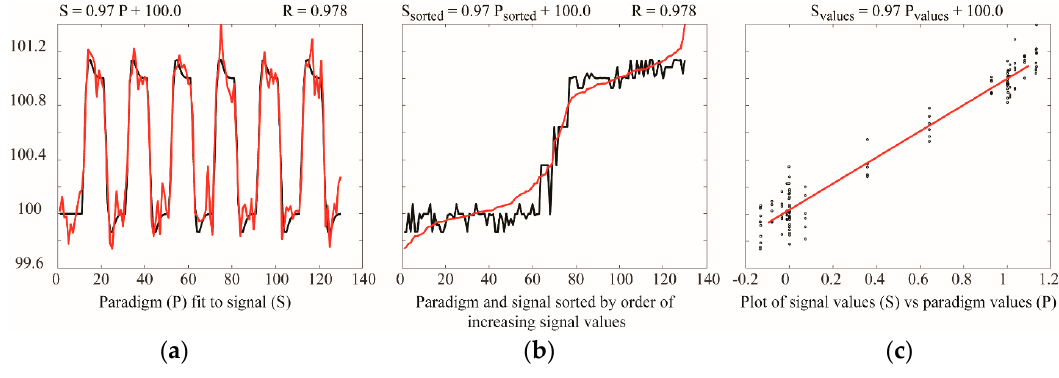
Figure 5. Simulations of data analysis concepts for the purpose of this review article. The left panel ( a ) shows a model paradigm, P (black), fit to a simulated signal, S (red), consisting of a 1% BOLD signal change from a baseline value of 100, plus random noise. The results of a GLM fit are shown: S = 0.97 P + 100.0. The correlation between the paradigm and signal is shown as R = 0.978. The middle panel ( b ) shows the effect of sorting both the paradigm values and the signal values to order the signal values in increasing order. The results of the GLM fit and correlation are unchanged. The right-most panel ( c ) shows a plot of signal values versus paradigm values, and a linear fit between them. The fit and correlation results are again the same.